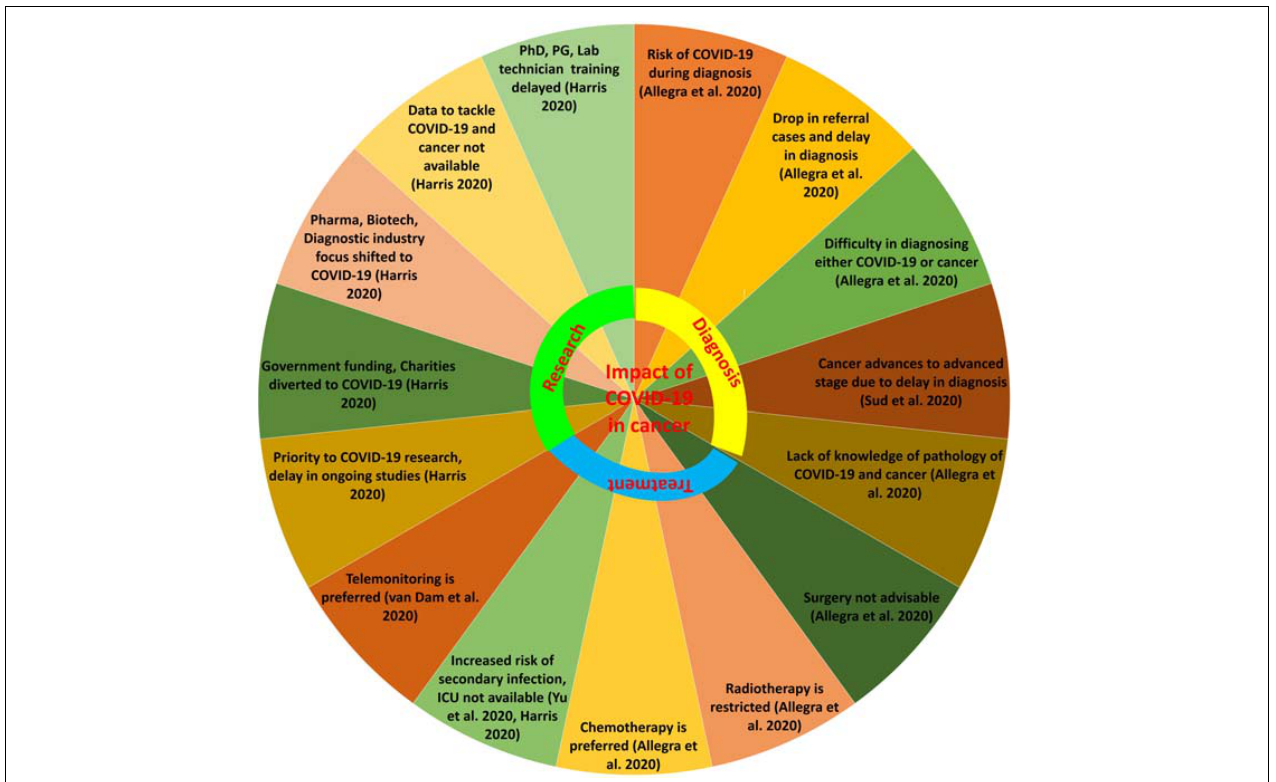
FIGURE 2 | Impact of COVID-19 on cancer. Impact on diagnosis, treatment, and